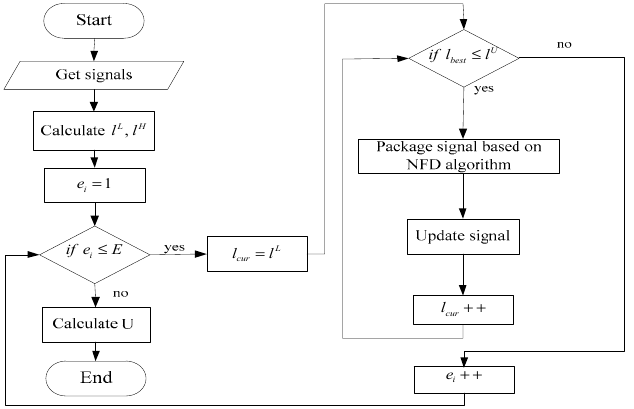
Figure 3. Frame packing flow chart.